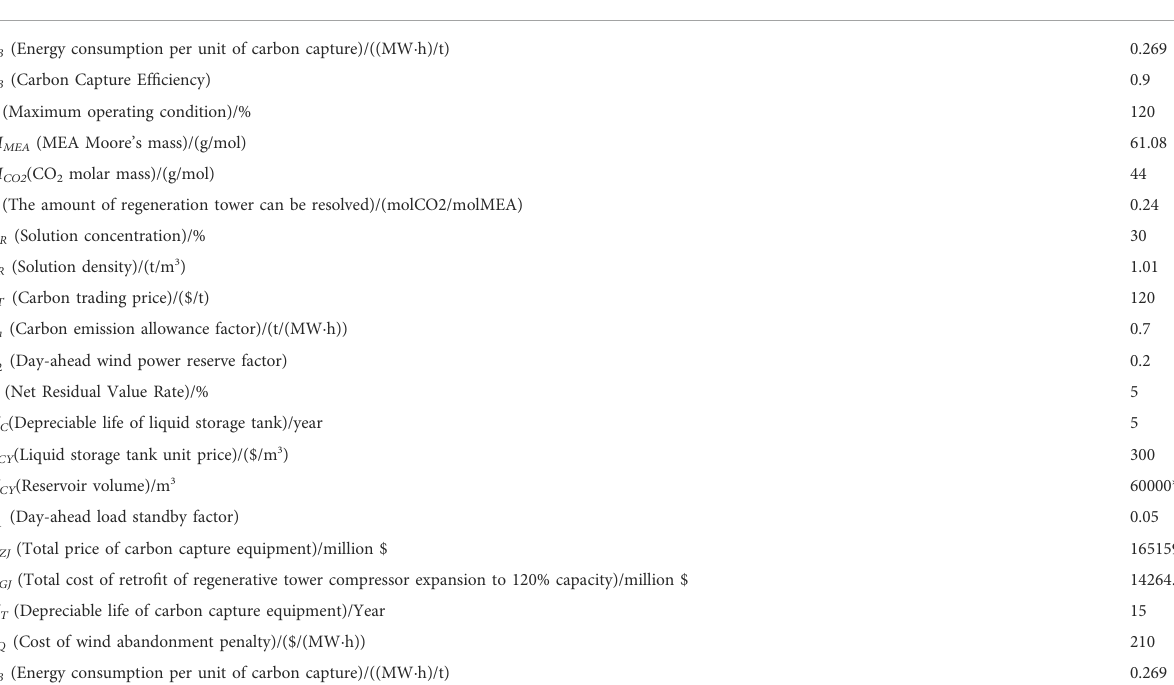
TABLE 2 Other system parameters (Mainly system size parameters and carbon capture plant operating and cost parameters) (Yu et al.,